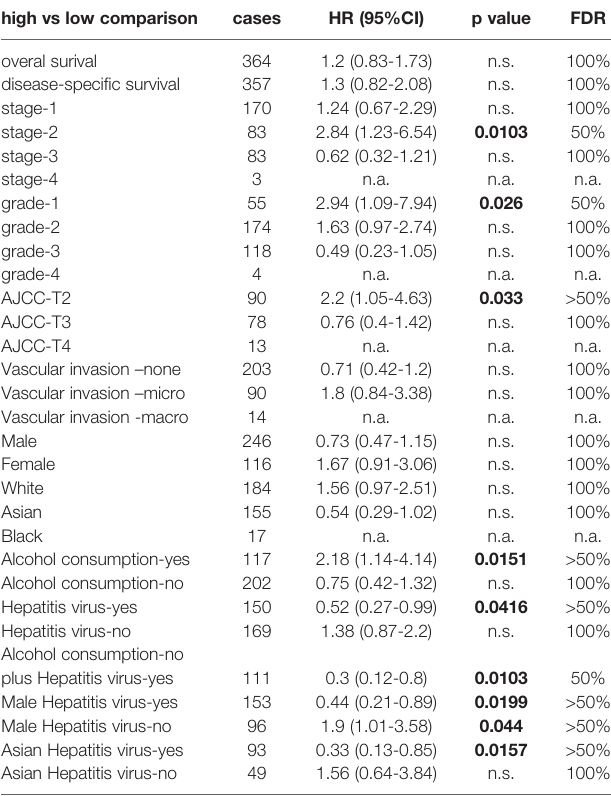
TABLE 1 | The Kaplan Meier plotter was used to calculate the hazard ratio with 95% con fi dence intervals and log-rank p -value after stratifying the cohort into different subgroups based on the clinical and pathological